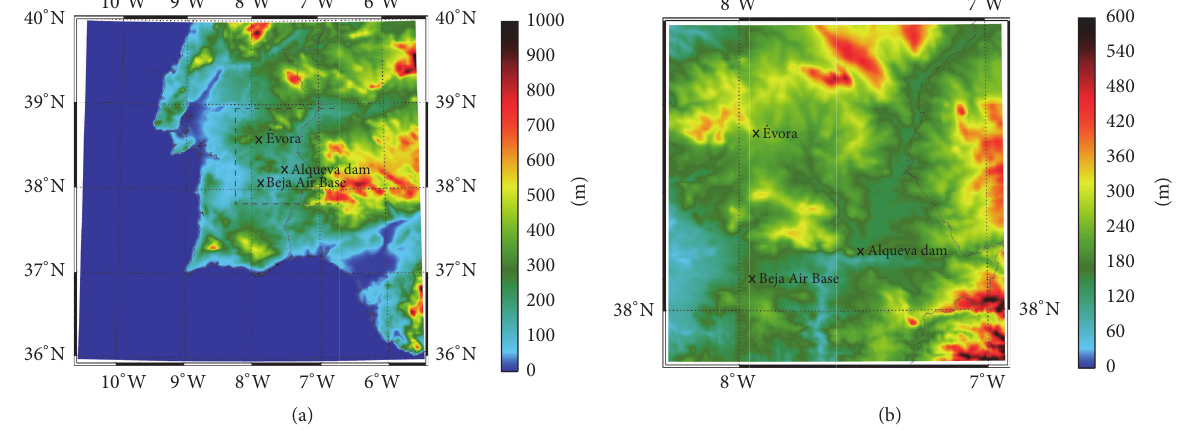
Figure 3: Orography of domains D1 and D2.